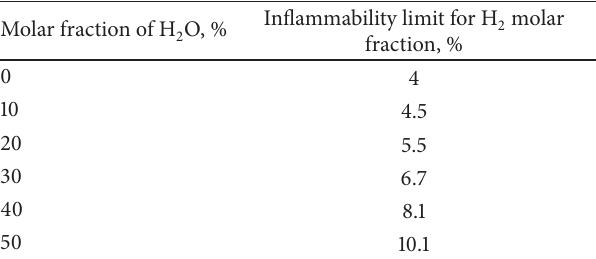
Molar fraction of H